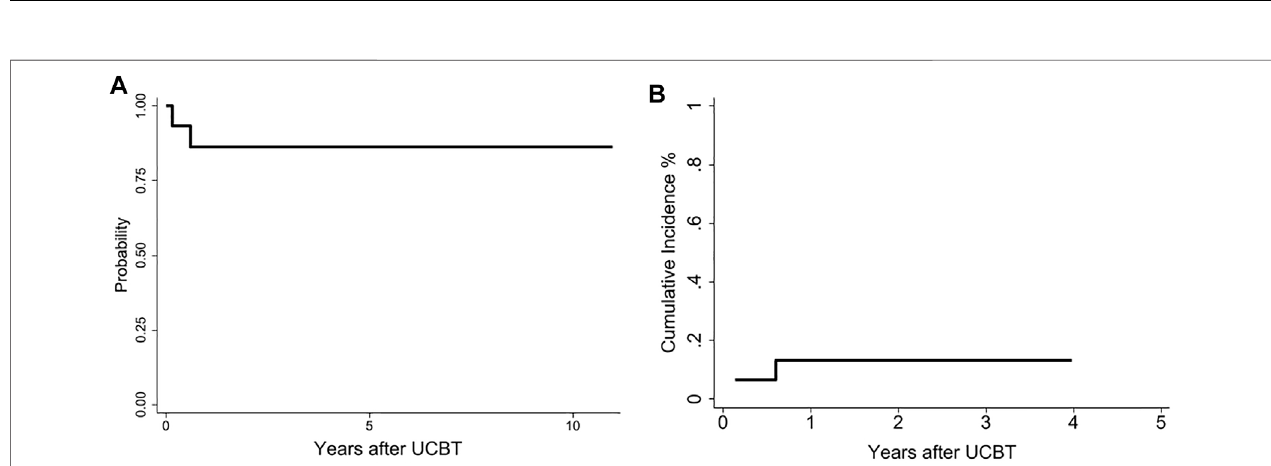
FIGURE 4 | Disease free survival at 10 years: recipients ex-vivo expanded cells 86% (95% CI: 56 – 96) ( Figure 4A ). Cumulative incidence relapse ( Figure 4B ).